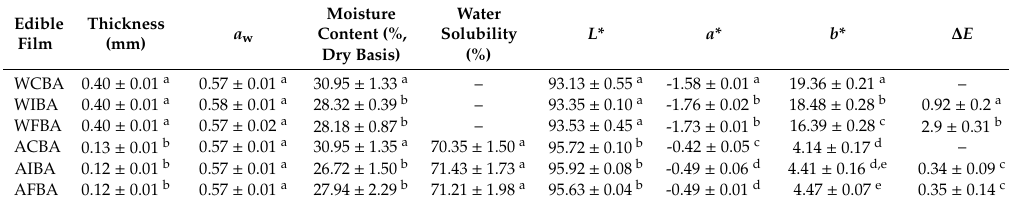
Table 2. Physicochemical and color properties of edible films containing B. animalis subsp. lactis BB-12 and di ff erent types of prebiotics fibres. The results are displayed as mean ± standard deviation of the film samples ( n =